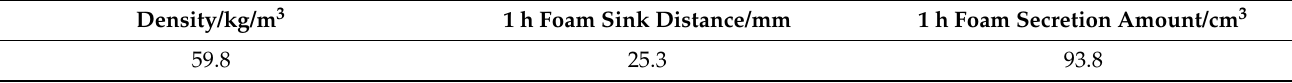
Table 7. Physical properties of